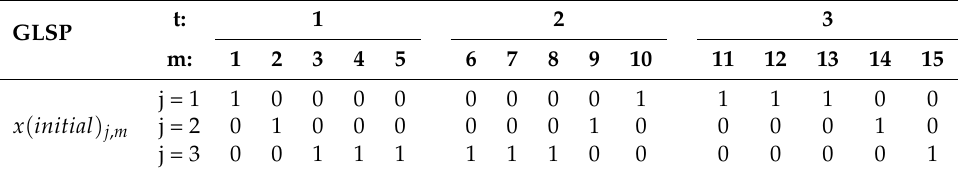
Table 5. Production sequence of the initial solution for the GLSP-RP.